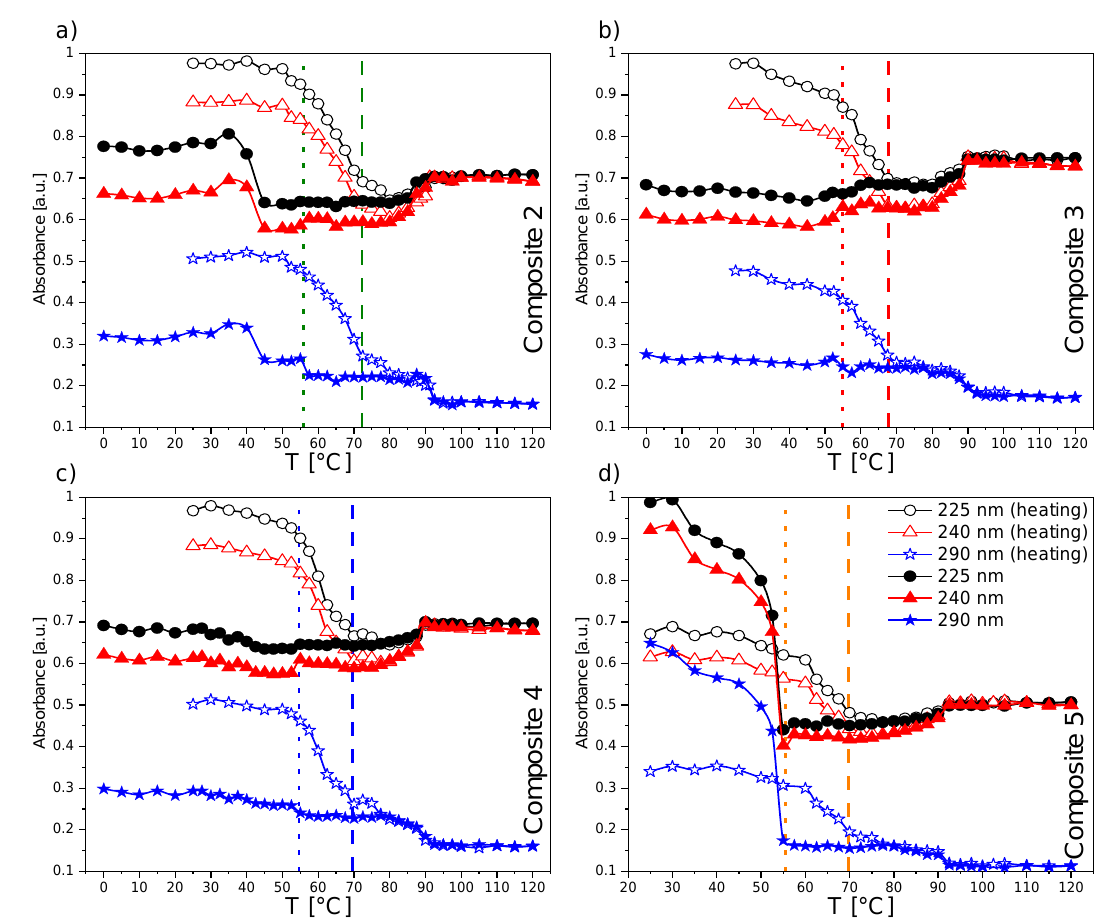
Figure 4. Influence of heating and cooling on the absorbance at 225, 240, and 290 nm for Composite 2 ( a ), Composite 3 ( b ), Composite 4 ( c ), and Composite 5 ( d ). The legend in graph ( d ) is the same for all graphs. The vertical dashed and dotted lines represent the SmA* – SmC* and SmC* – Cr 1 phase transition temperatures (during cooling), respectively.